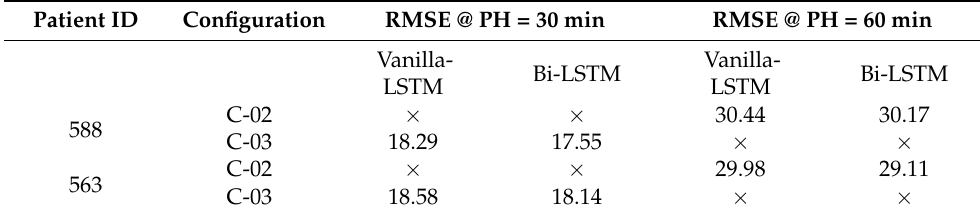
Table 4. Prediction error for patient ID 588 and 563.